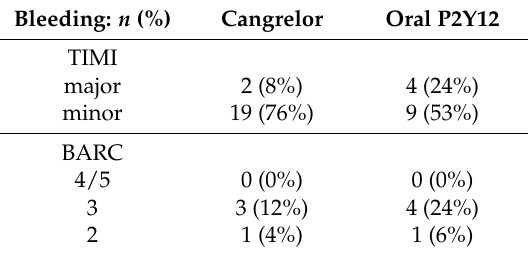
Table 2. Bleeding events in accordance to the TIMI classification (upper part) or the BARC classification (lower part) for the CANGRELOR group (left) and the ORAL P2Y12 group (right). Bleeding: n (%) Cangrelor Oral P2Y12